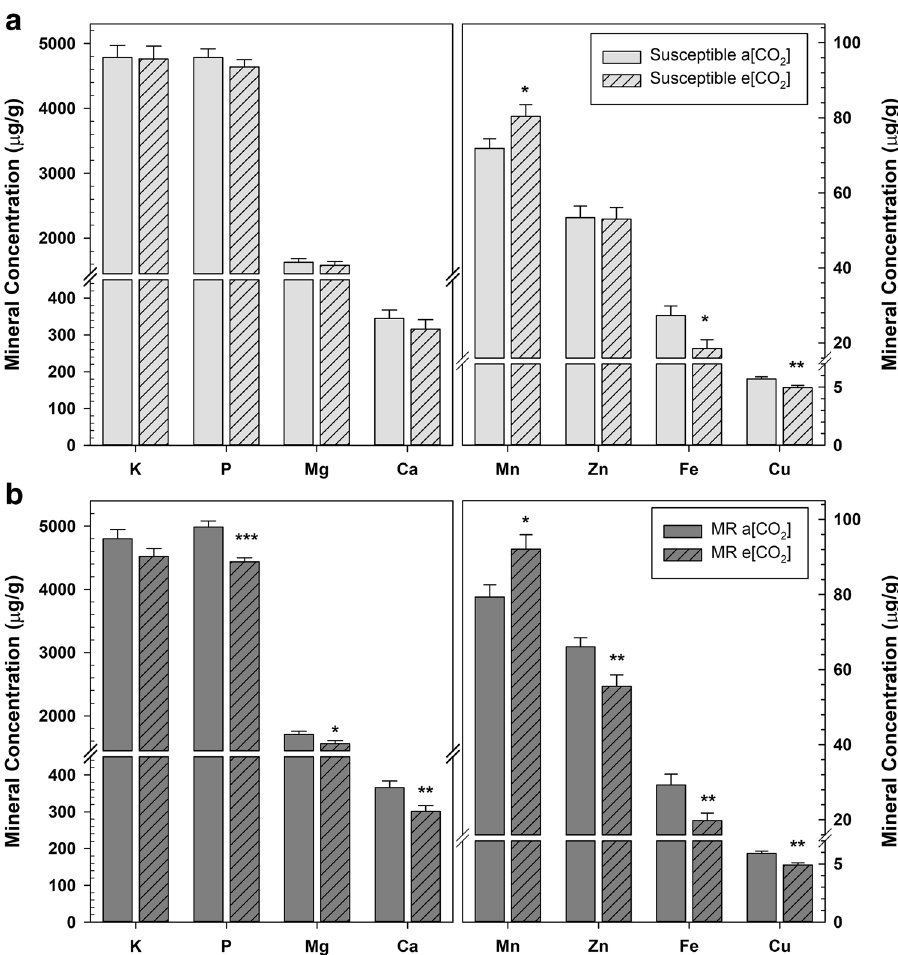
Figure 6. Mineral content of susceptible ( a ) and moderately resistant (MR) ( b ) wheat grain grown at ambient CO 2 (a[CO 2 ]) and elevated CO 2 (e[CO 2 ]). Error bars represent standard error and asterisks (*, **) denote statistically significant differences in the mineral content of wheat grown at a[CO 2 ] and e[CO 2 ] by Fusarium head blight (FHB) resistance group, as determined by a Tukey adjusted generalized mixed model analysis of variance ( P < 0.05, P < 0.01, respectively); MR ( n = 27), and susceptible ( n = 18), for each CO 2 growth